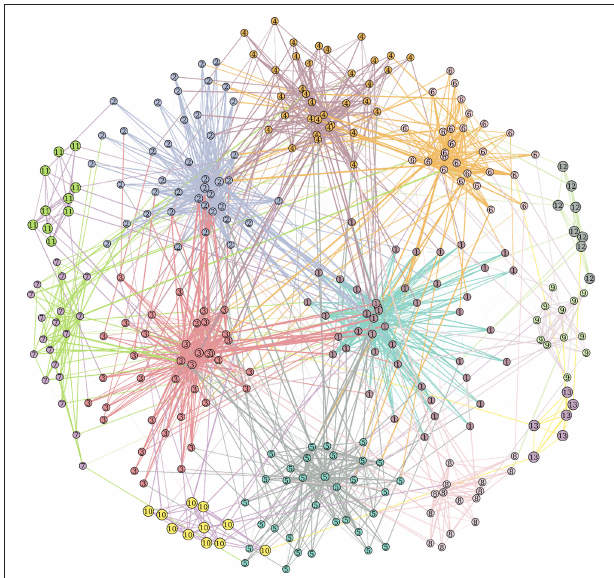
FIGURE 1 | Example of benchmark LFR network with parameters N = 300, h k i = 12, max k = 50, µ t = µ w = 0.2, min c = 5, max c = 50.